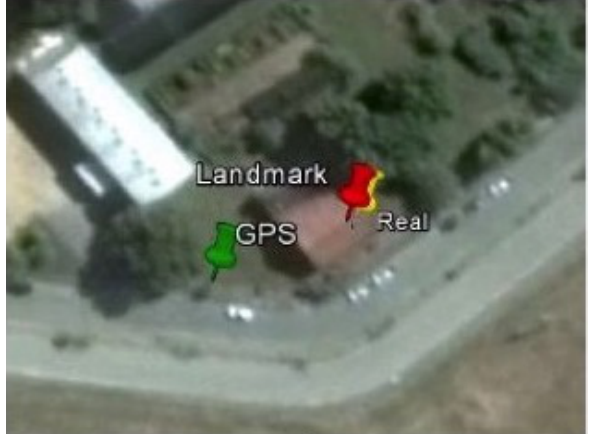
Figure 6. Auto-localization position comparison between GPS, Landmark Recognition Estimation, Real UAV Position in the house landmark.